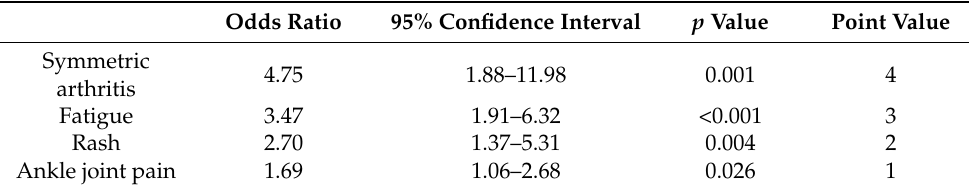
Table 4. Multivariate analysis of predictors of CHIKV